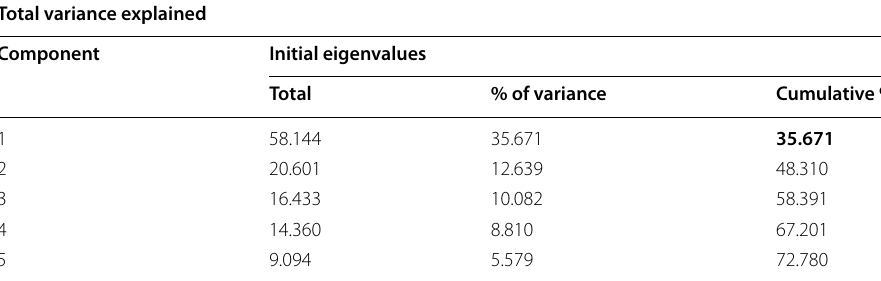
Table 4 The highest components of PCA for the first runs Total variance explained Component Initial eigenvalues Total % of variance Cumulative